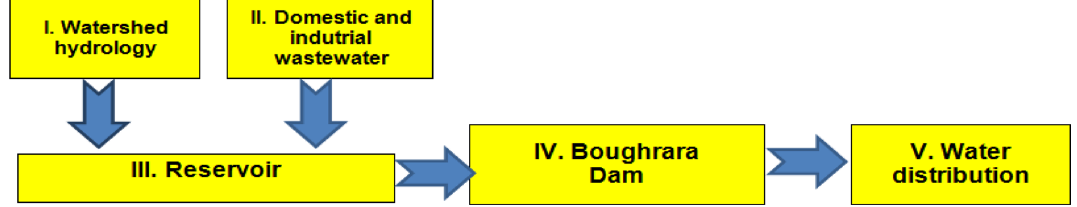
Fig.1 Functional chronology of the system Boughrara